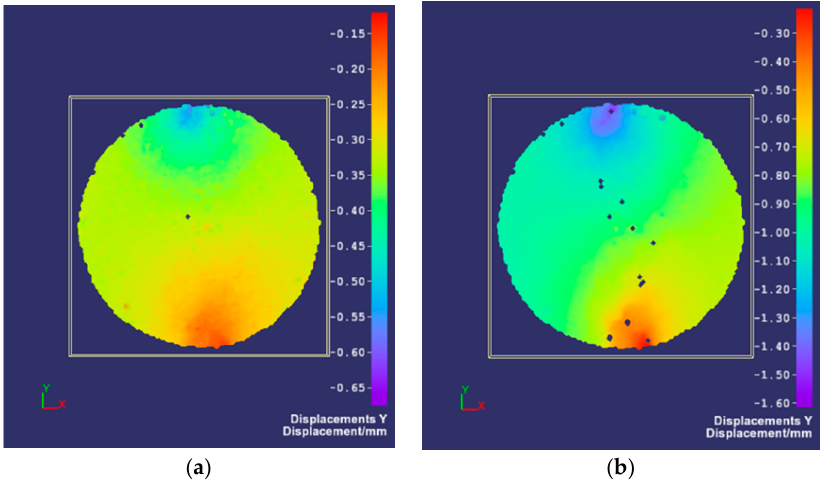
Figure 12. Vertical displacement of the HMA sample in the indirect tensile test: ( a ) The distribution of horizontal displacements, the load of 0.8 kN; ( b ) advanced phase of the test—the formation of local cracks (discontinuities), the load of 1.7 kN [25].